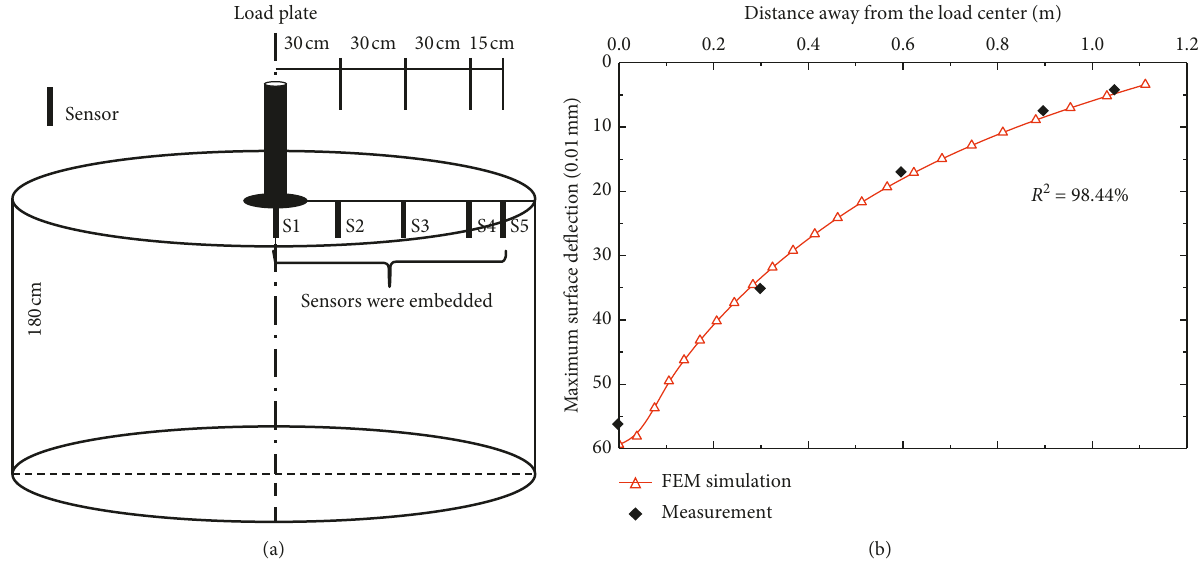
Figure 4: Laboratory tank test and FEM model of the flexible pavement: (a) size of the laboratory tank model; (b) results between measurement and FEM calculation.